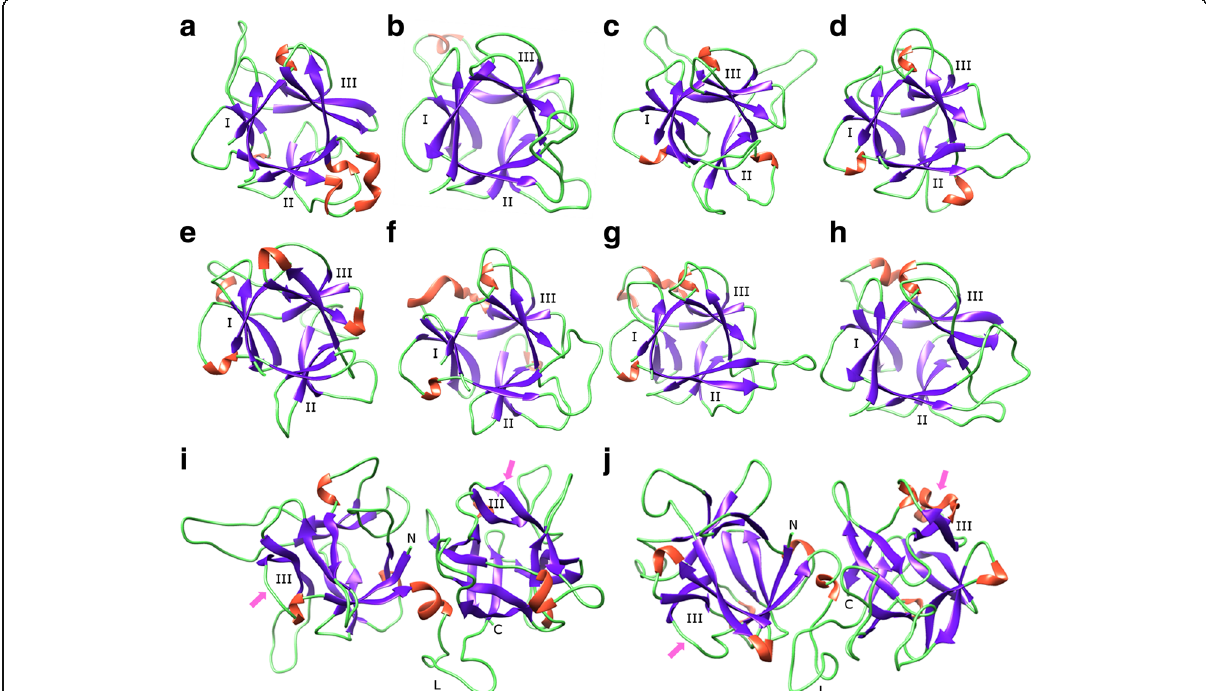
Fig. 3 Ribbon diagrams of the β -trefoil lectin domains of O. sativa EULs. a - h . Ribbon diagrams of the separate EUL domains of OsEULS2 ( a ), OsEULS3 ( b ), OsEULD1A_1 ( c ), OsEULD1A_2 ( d ), OsEULD1B_1 ( e ), OsEULD1B_2 ( f ), OsEULD2_1 ( g ), and OsEULD2_2 ( h ). Beta-sheets, stretches of α -helices and loops are colored magenta, orange and green, respectively. The bundles of β -sheet are numbered I, II and III, respectively. The carbohydrate-binding site of the EUL domain is located at the bundle III. i - j . Ribbon structure of the two- β -trefoil domain OsEULD1A ( i ) and OsEULD1B ( j ), showing the respective arrangement of the two β -trefoil domains on both sides of the central linker region (L). The arrow indicates the carbohydrate-binding site in subdomain III. N and C correspond to the N- and C-terminal ends of the polypeptide chain of OsEULD1A and OsEULD1B,